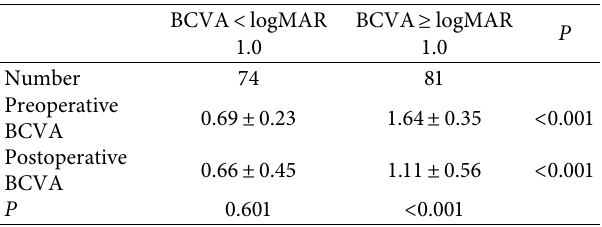
Table 4: Preoperative and postoperative BCVA of two groups separated by baseline visual acuity.